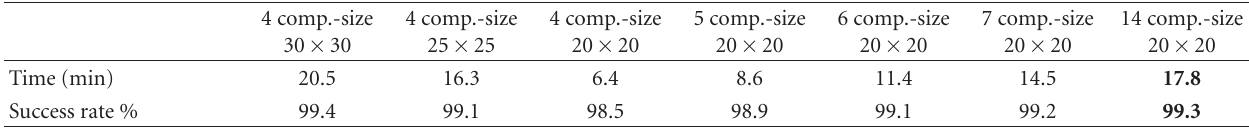
Table 7: The time consumed (in minutes) and the success recognition rate for the di ff erent number of components using the xm2vts (C2) database. 4 comp.-size Time (min) Success rate % Table 8: The time consumed (in minutes) and the success recognition rate for the di ff erent number of components using the FERET (Fb) database. 4 comp.-size Time (min) Success rate % Table 9: The time consumed (in minutes) and the success recognition rate for the di ff erent number of components using the Yale database. 4 comp.-size 30 × 30 Time (min) Success Rate %